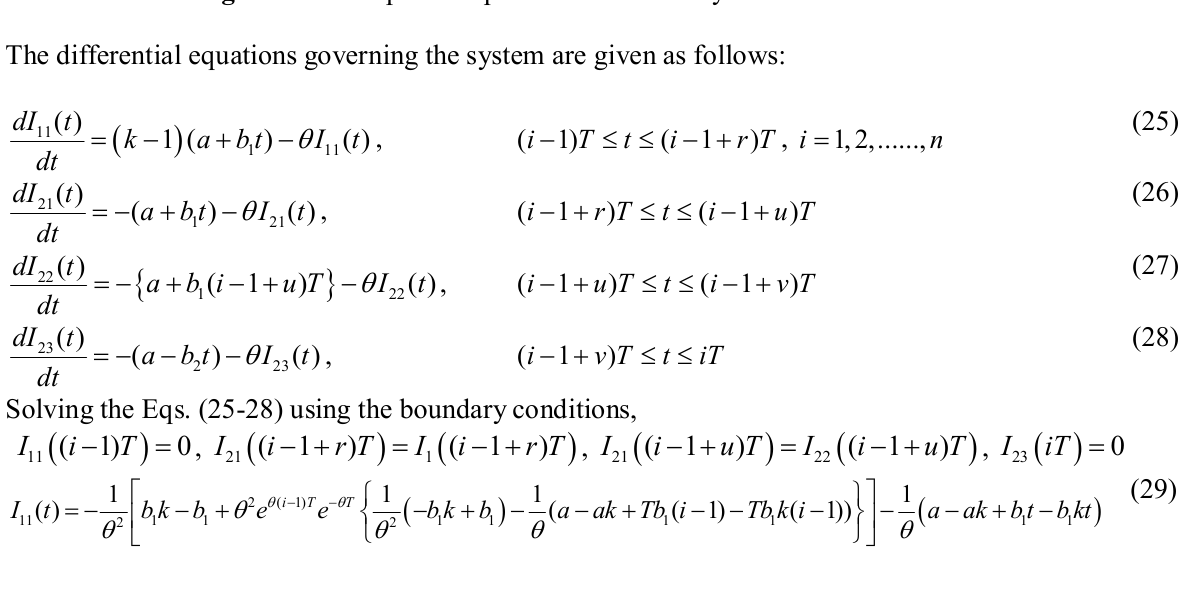
Fig. 3. Graphical representation of the system for Case